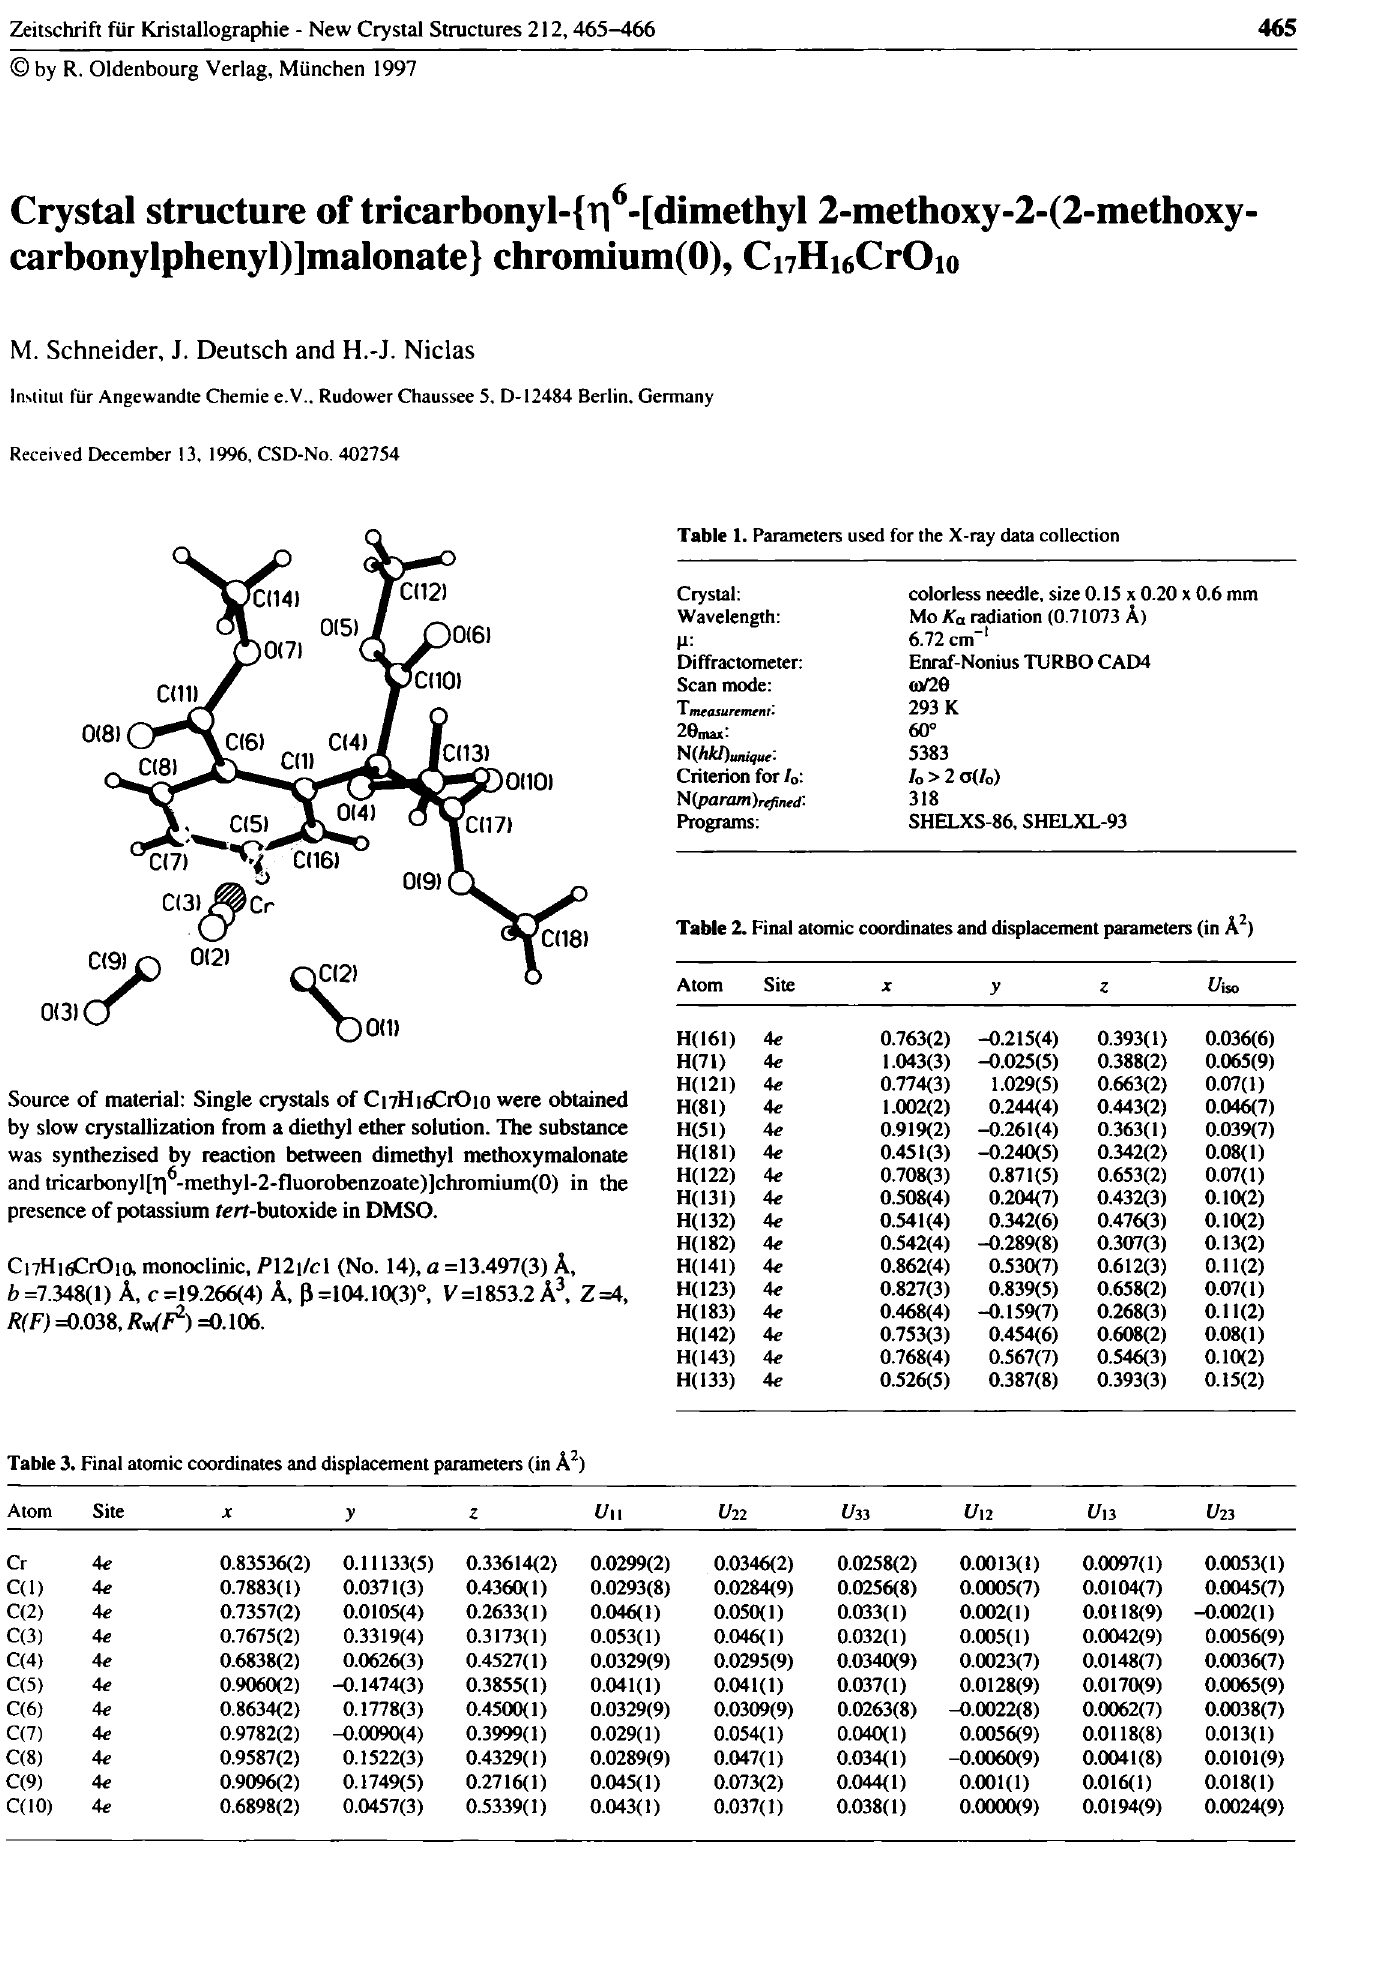
Table 1. Parameters used for the X-ray data collection